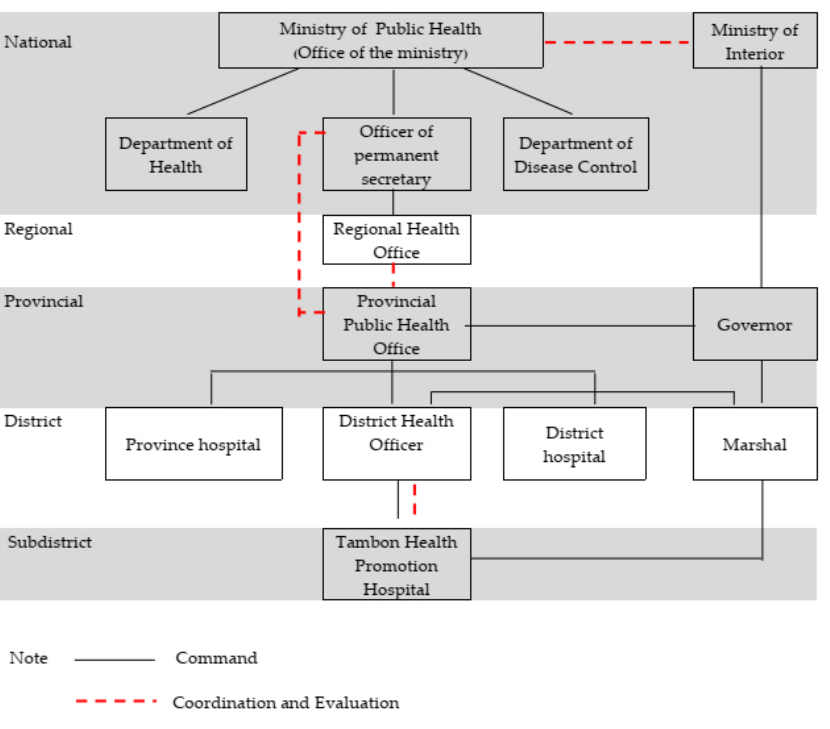
Figure 1. The network of public health departments in Thailand.